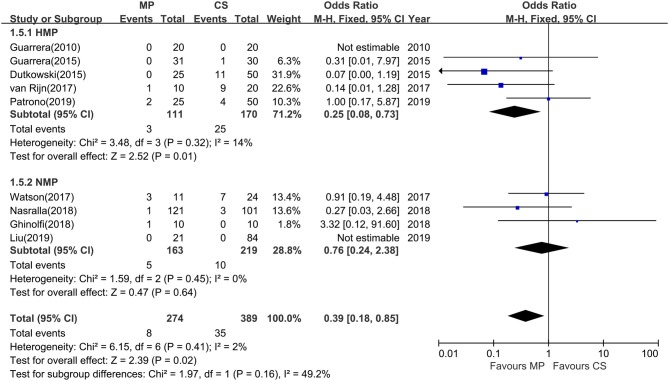
Meta-analysis on ischemic cholangiopathy rates between MP and CS preservation. HMP reduced the ischemic cholangiopathy rates (OR = 0.25; 95% CI = 0.08–0.73; P = 0.01), and NMP cannot reduce the ischemic cholangiopathy rates (OR = 0.76; 95% CI = 0.24–2.38; P = 0.64). Data are expressed as OR ± 95% CI. MP, machine perfusion; CS, cold storage; HMP, hypothermic machine perfusion; NMP, normothermic machine perfusion; CI, confidence interval.